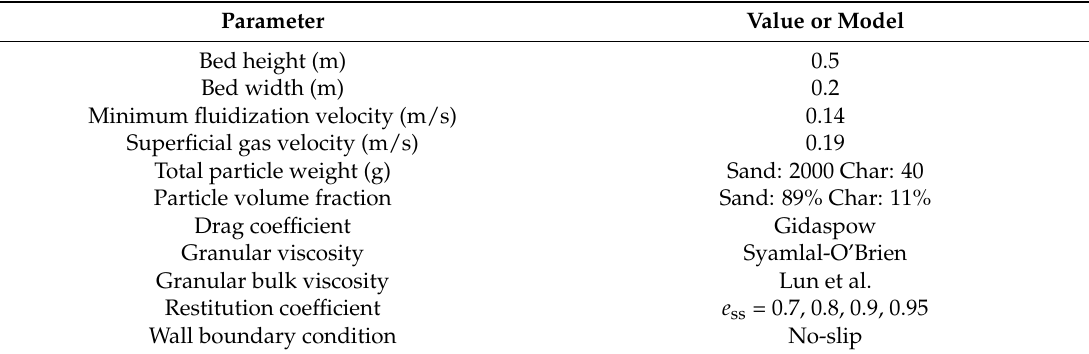
Table 2. Summary of the simulation parameters.